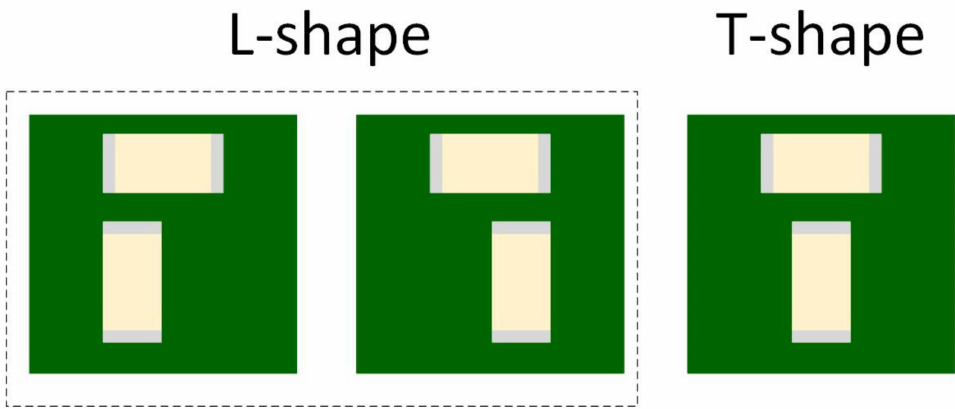
Figure 10. L-shape and T-shape layout